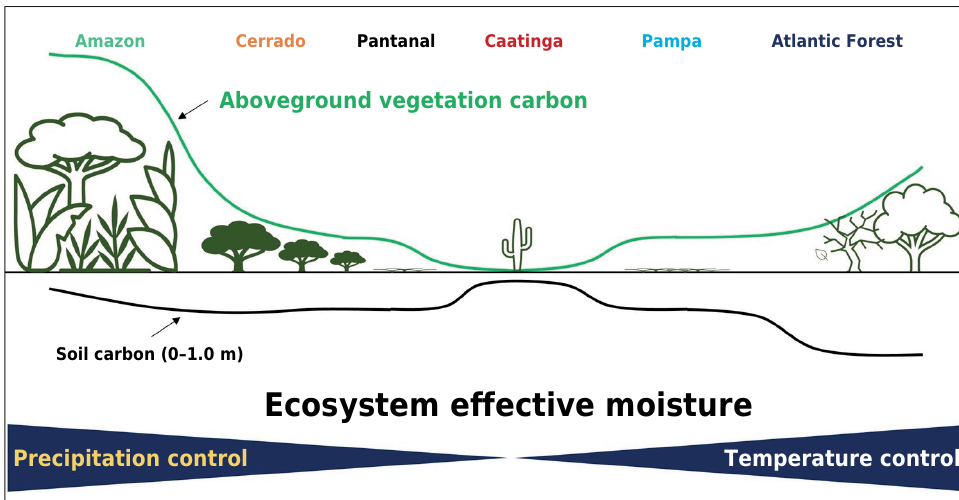
Figure 4. Conceptual model to describe the control of temperature and precipitation on ecosystem effective moisture (EEM), which in turn determines the partition of C and vegetation and soils across the six major Brazilian biomes: Amazon, Cerrado, Pantanal, Caatinga, Pampa and Atlantic